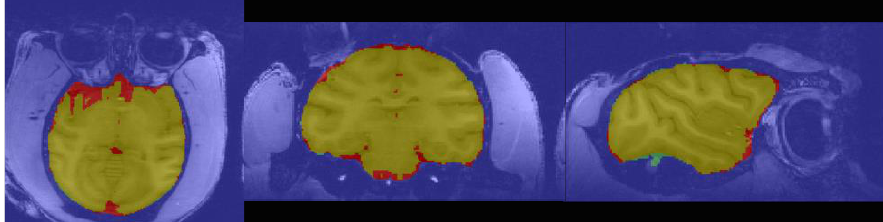
Figure 6. Schematic diagram of the segmentation results of the algorithm. The yellow area means true positive ( TP ); blue area means false positive ( FP ); green area means true negative ( TN ); and red area means false negative ( FN ).